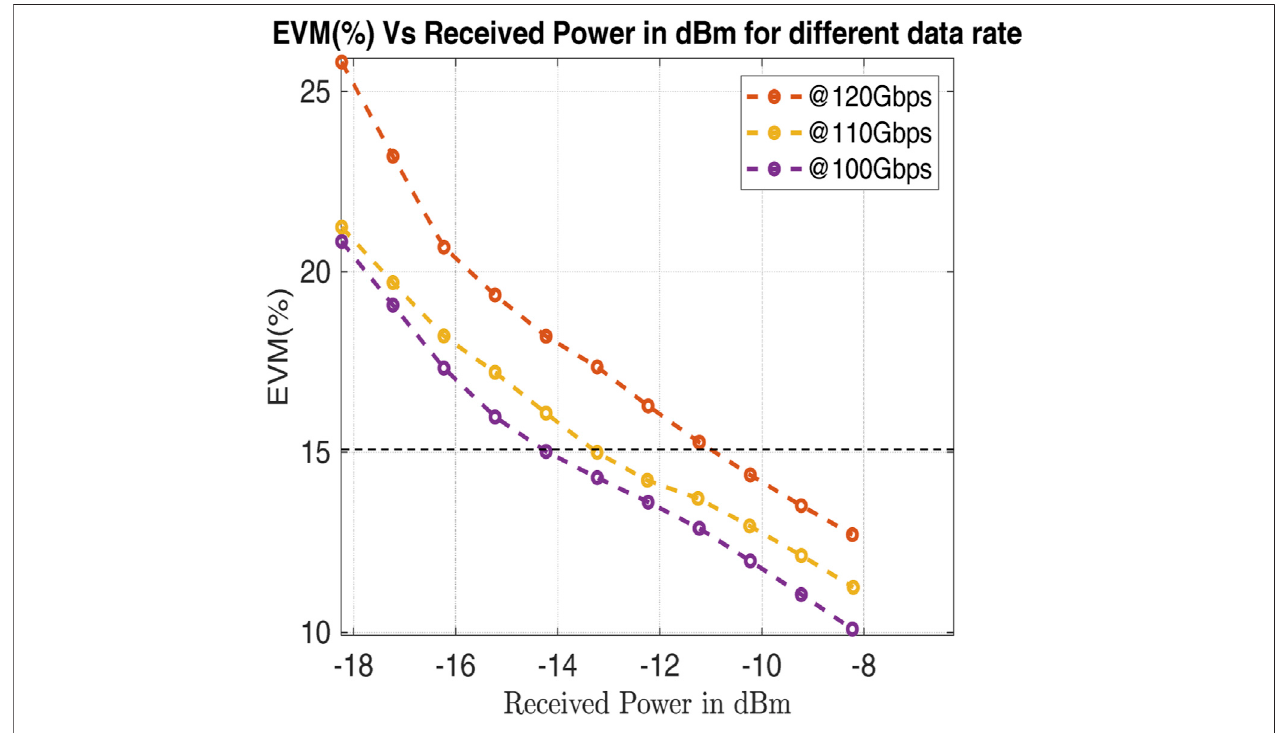
FIGURE 12 | Received power vs EVM%.